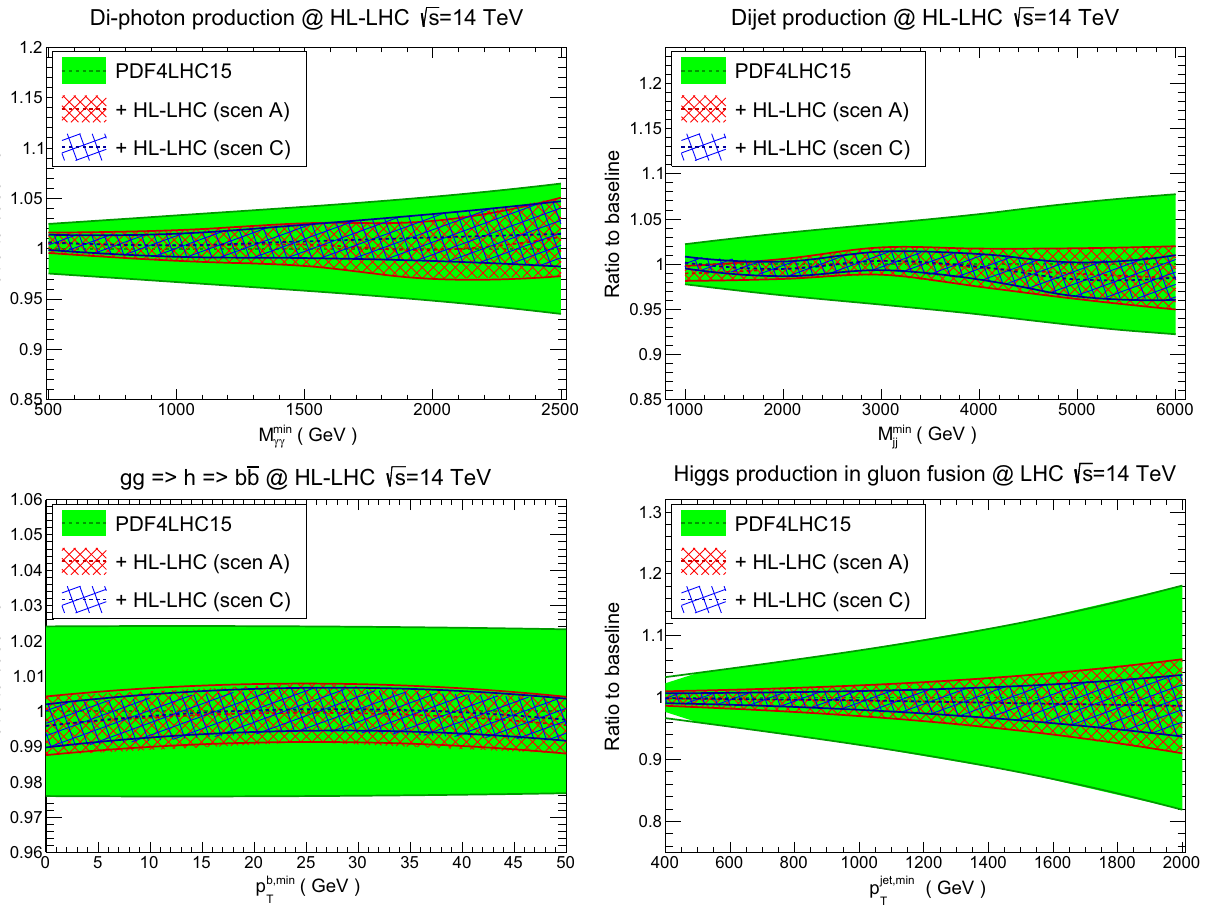
Fig. 19 Comparison of the predictions for representative SM cross √ s = 14 TeV between the PDF4LHC15 baseline and the sections at HL–LHCprofiledsetsintheconservative(A)andoptimistic(C)scenar- ios. Results are shown normalised to the central value of PDF4LHC15. The upper plots show the diphoton (left) and dijet (right plot) produc- tion cross sections as a function of the minimum invariant masses of the